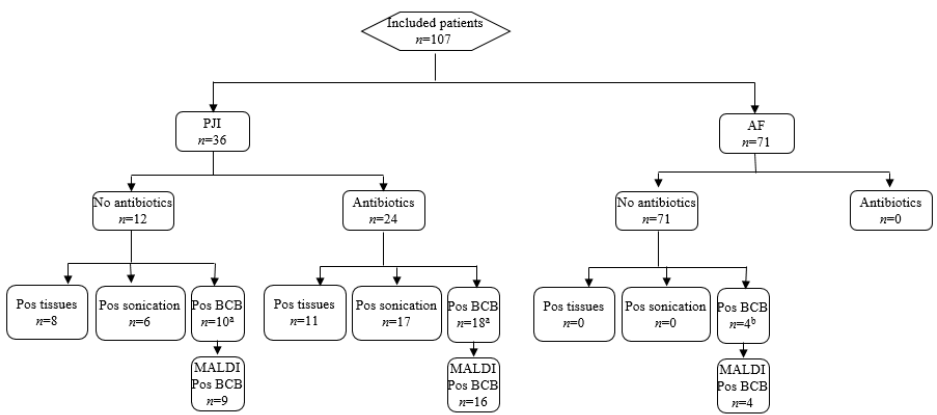
Figure 1. Concordance of sonication fluid cultures, periprosthetic tissue cultures and direct MALDI- TOF MS of positive blood culture bottles. Note: PJI, prosthetic joint infection; AF, aseptic failure; Pos, positive; Neg, negative; BCB, blood culture bottles. a Two cases (3%) had growth of low-virulent microorganisms below the cut-off (50 CFU/mL); b Two coagulase negative staphylococci (CNS) and two Cutibacterium acnes.